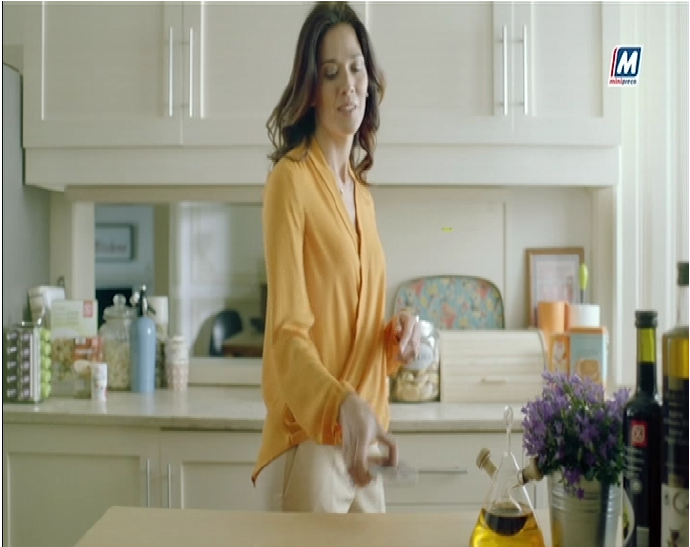
Figure 5. Advertisement with the brand’s logo in top right corner.